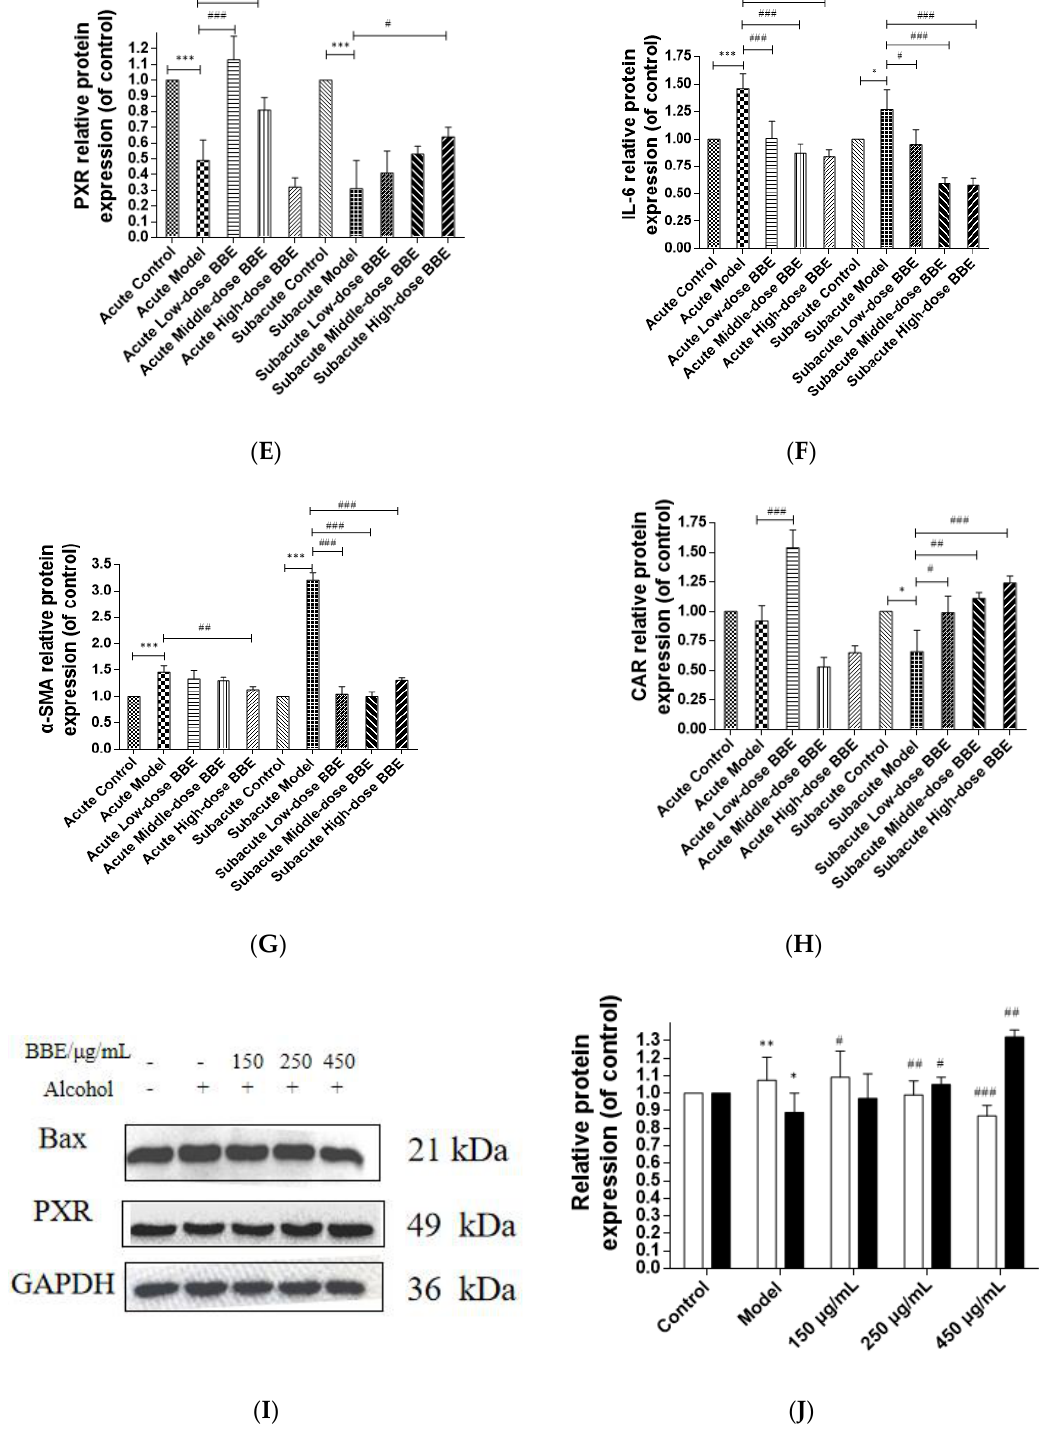
Figure 8. Effects of BBE on the expression of PXR/PI3K/Akt pathways in liver and HepG2 cells ( A – J ). Western blotting analysis of NF- κ B, TGF- β , PXR, IL-6, α -SMA in livers, and the datas were normalized to that of GAPDH ( A – H ), Western blotting analysis of Bax, and PXR in HepG2 cells, and the datas were normalized to that of GAPDH (I-H). Values are the mean ± standard deviation. Compared with control: *, p < 0.05, **, p < 0.01, ***, p < 0.001. Compared with model: # , p < 0.05, ## , p < 0.01. ###, p < 0.001.